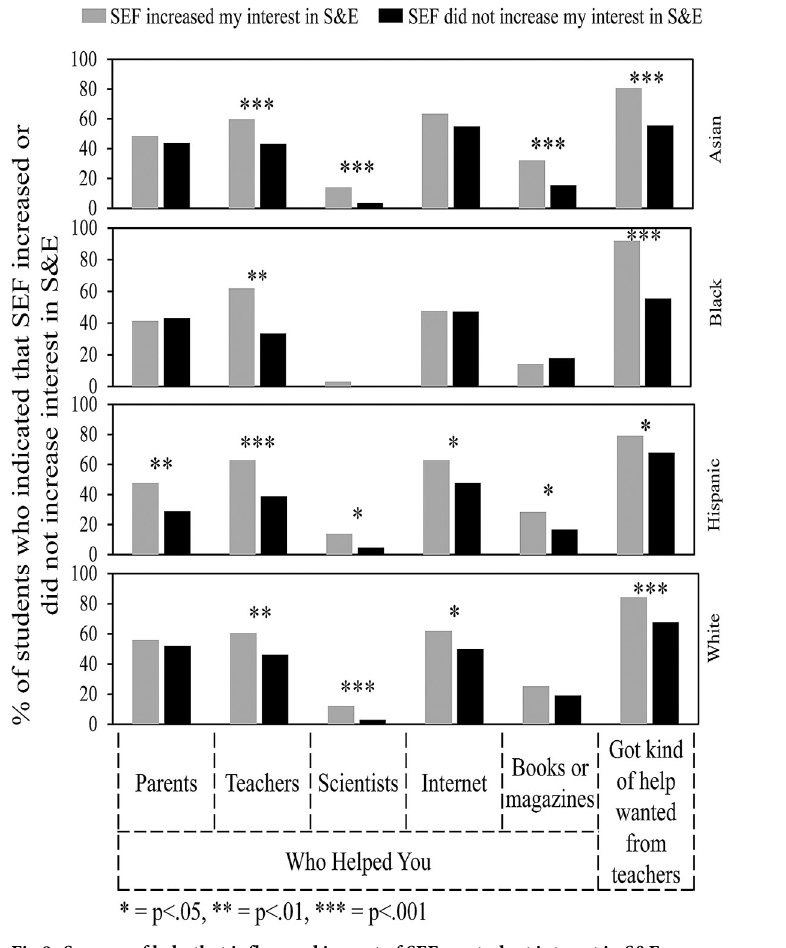
Fig 8. Sources of help that influenced impact of SEF on student interest in